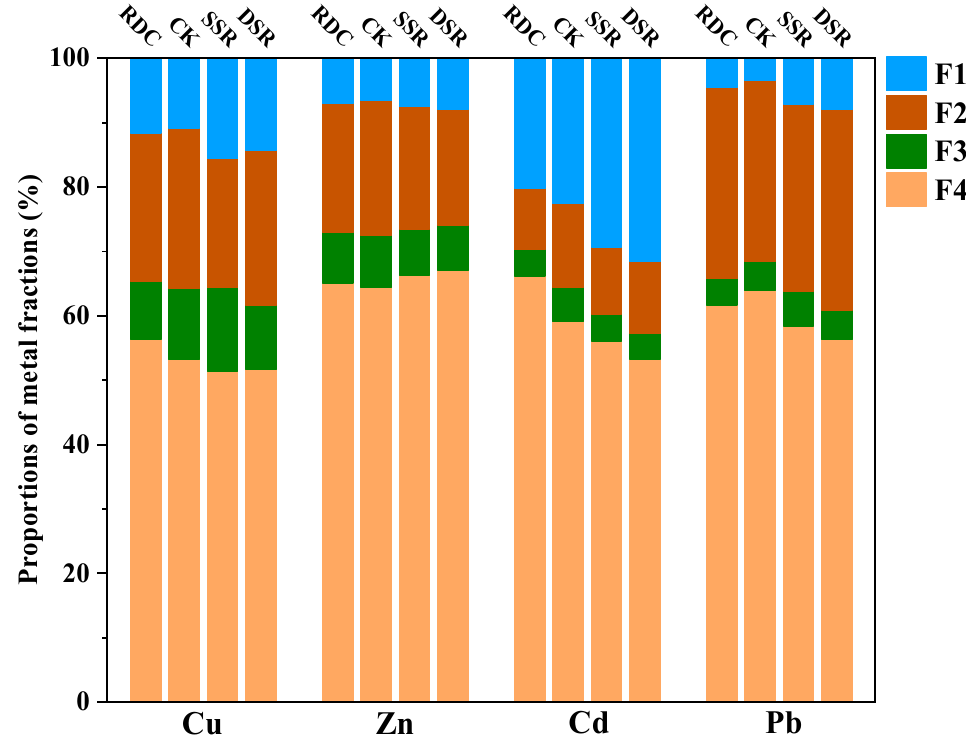
Figure 10. Chemical fractions of HMs in surface soils of paddy fields. F1, the acid-soluble fraction; F2, the reducible fraction; F3, the oxidizable fraction; F4, the residual fraction.